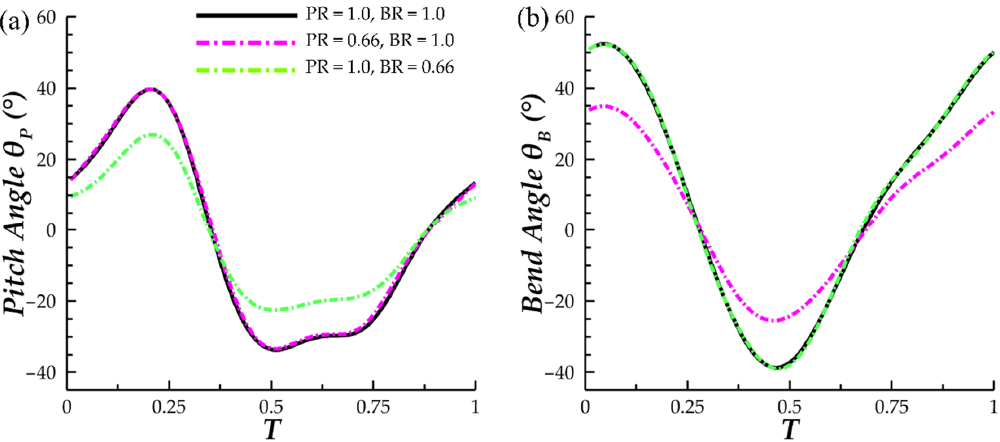
Figure 3. Comparison of ( a ) θ P and ( b ) θ B at pectoral fin span s/S = 0.5 for three PR and BR combi- nations.